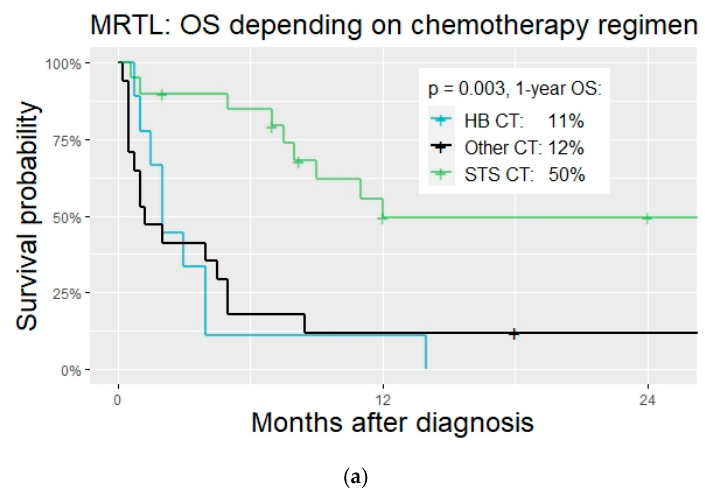
Figure 4. Overview of applied chemotherapy regiments in patients with MRTL vs. SCUD.